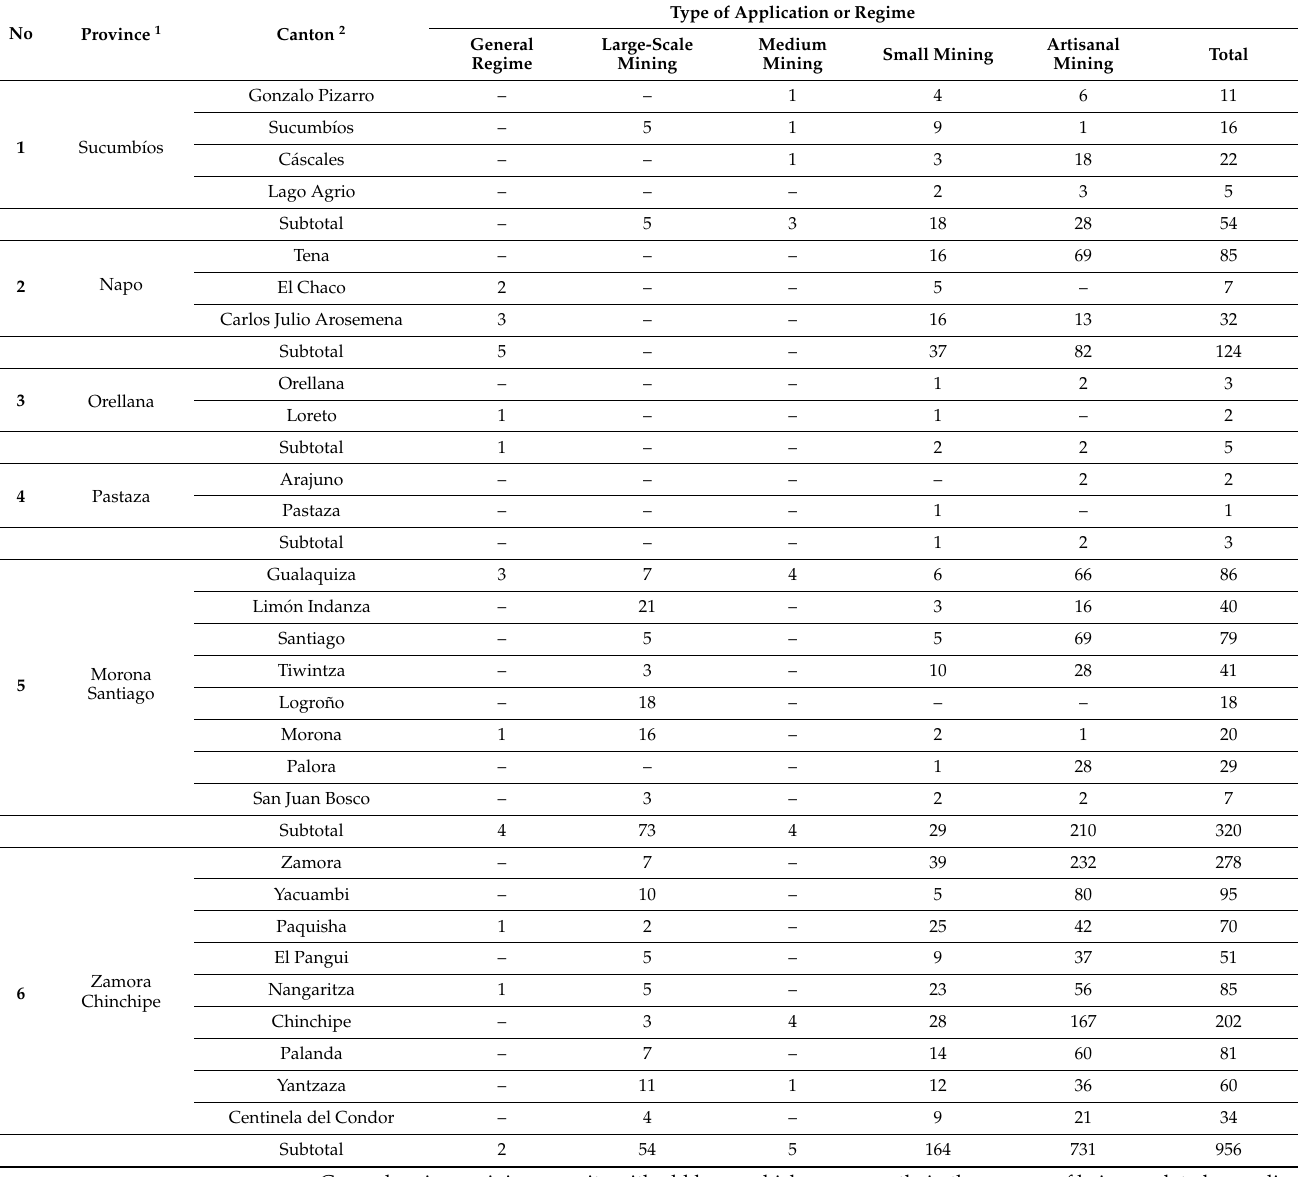
Table 1. Registered gold mining concessions in Ecuador’s Amazon